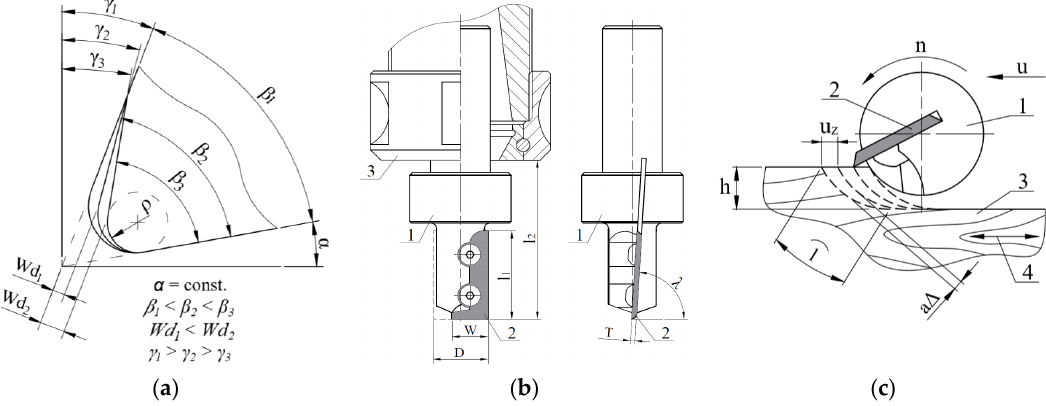
Figure 2. Cutting tool and down milling processing modes: ( a ) Measurement scheme of the wear of the cutting edge, α: clearance angle; β: sharpness angle; γ: rake angle; ρ: cutting edge radius; Wd : wear; ( b ) Fixation of cutter; 1: fixed milling tool; 2: cutter; 3: HSK 63F gripper device; ( c ) Down milling scheme: 1: milling tool; 2: cutter; 3: oak wood; 4: direction of the wood fiber; h : radial depth of cut; u z :